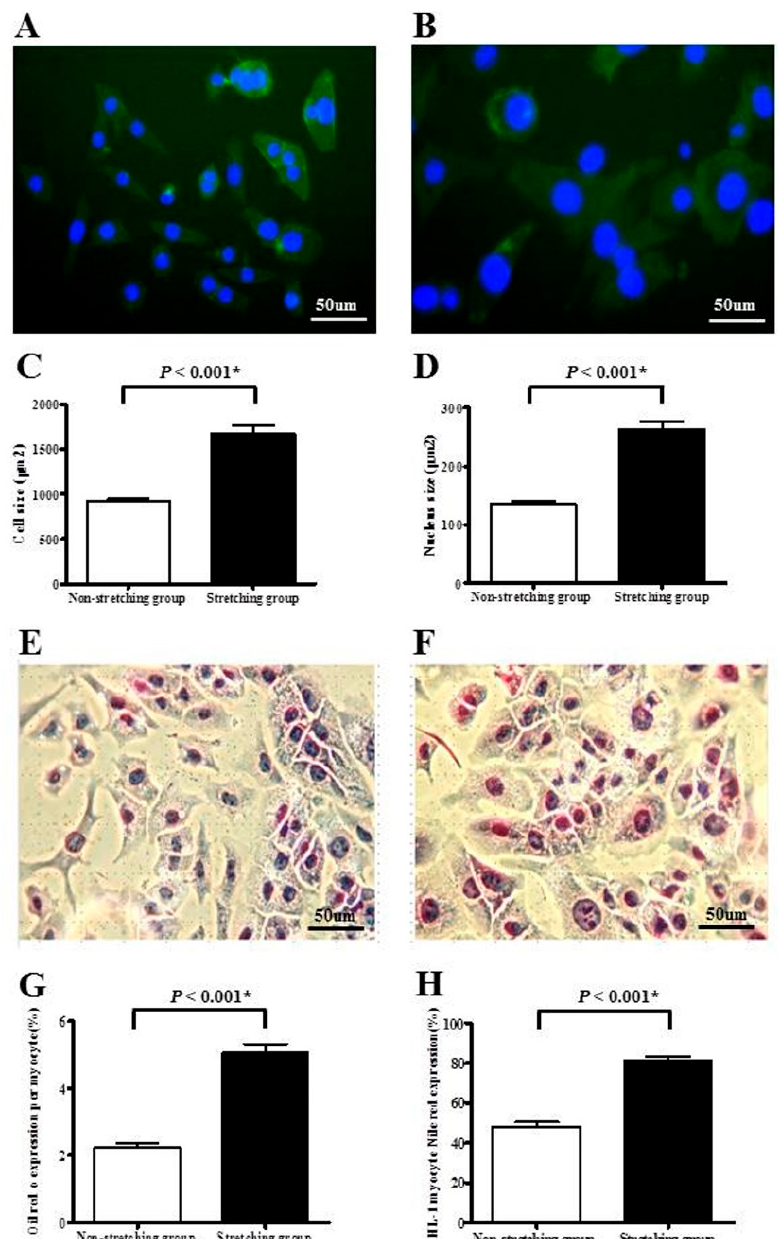
Figure 1. Immunofluorescence study of cell size and nucleus size of HL-1 atrial myocytes in non-stretched control group ( A ) and stretched group ( B ). Myocytes were identified with F-actin (green color). Nuclei were identified with DAPI (4 ′ ,6-diamidino-2-phenylindole) (blue color). Comparison of cell size ( C ) and nucleus size ( D ) between stretched and non-stretched HL-1 atrial myocytes. Histochemical analysis of lipid expression of HL-1 atrial myocytes in non-stretched control group ( E ) and stretched group ( F ). Comparison of Oil Red O-stained area per myocyte ( G ) and fraction of myocytes expressing Nile red ( H ), between the non-stretched control group and stretched group. * p < 0.05. Bar = 50 µm.